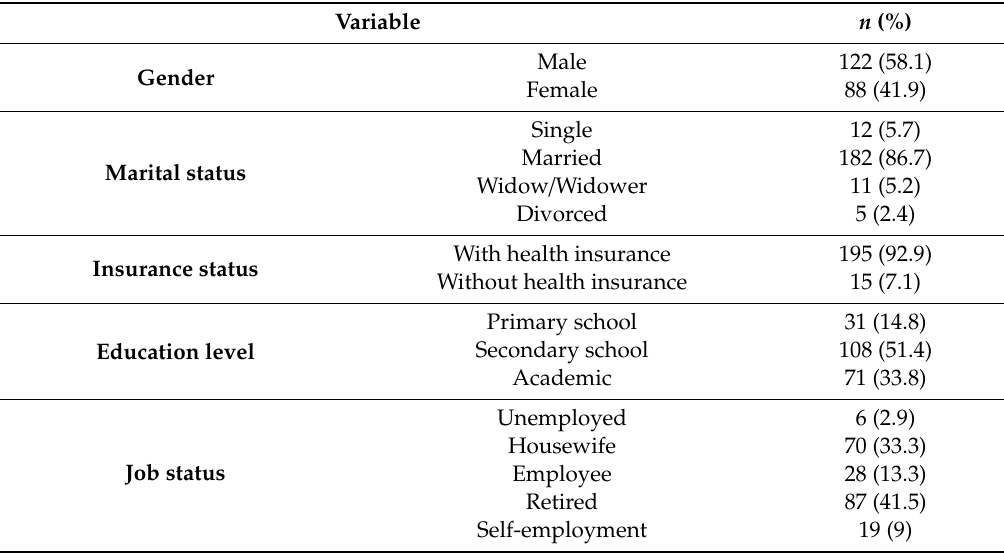
Table 2. Demographical characteristics of the subjects ( n =